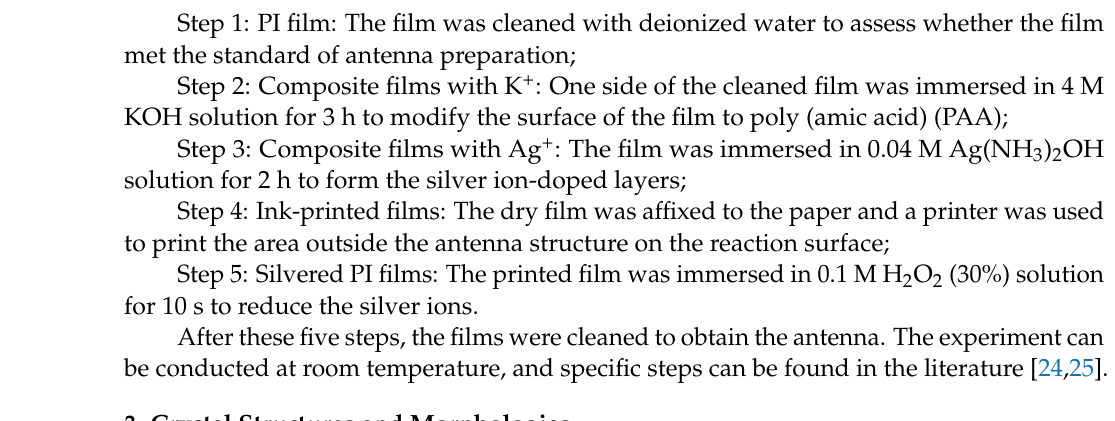
Figure 3. The manufacture process of the antenna.